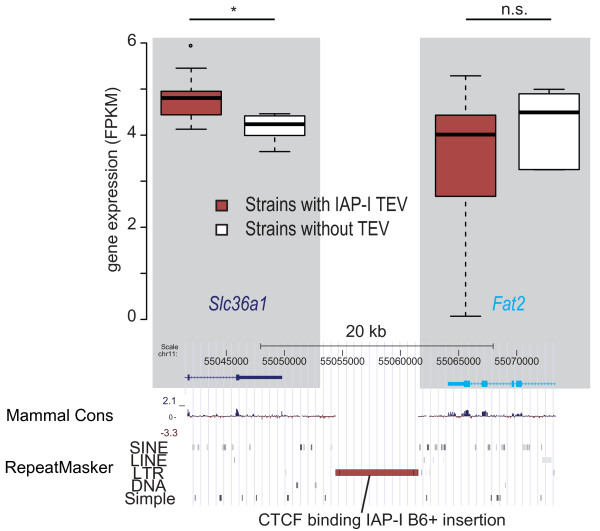
An example of a genomic region with a CTCF-binding TEV, in this case an IAP-I provirus. The presence of the IAP-I is associated with differential expression of Slc36a1 (P < 0.05, genome wide FDR 0.05) across the strains but not of Fat2. The IAP-I is present in the strains 129P2/OlaHsd, 129S1/SvImJ, 129S5/SvEvBrd, A/J, AKR/J, BALB/cJ, C3H/HeJ, C57BL/6NJ, CBA/J, DBA/2J, LP/J, NOD/ShiLtJ, CAST/EiJ, PWK/PhJ and WSB/EiJ.